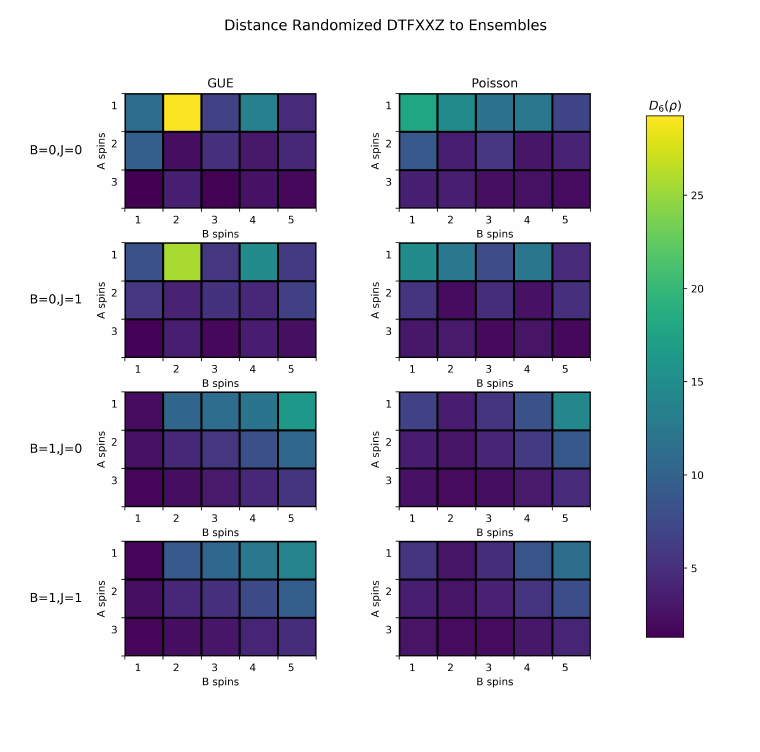
Figure 26: Left: Normalized distance of dynamics of Disordered XXZ Model (see equation 45) to analytical GUE. Right: to analytical